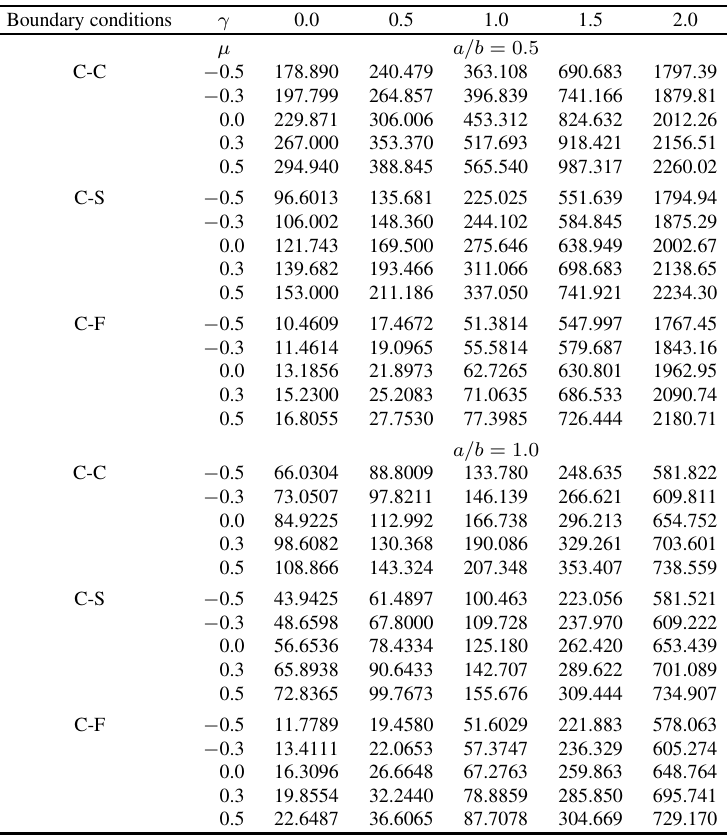
Table 1 Values of lowest critical buckling loads N ∗ cr for C-C, C-S, and C-F